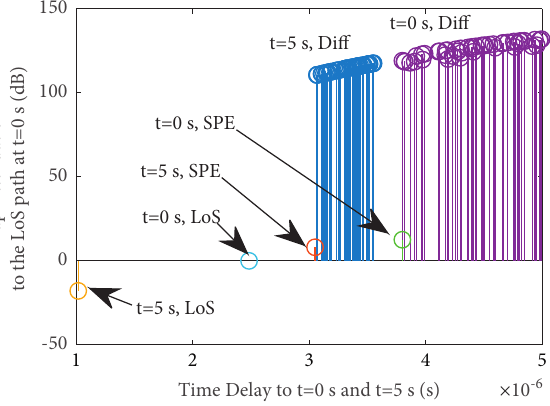
Figure 4: The CIRs at t � 0 s and t � 5 s (case 1).